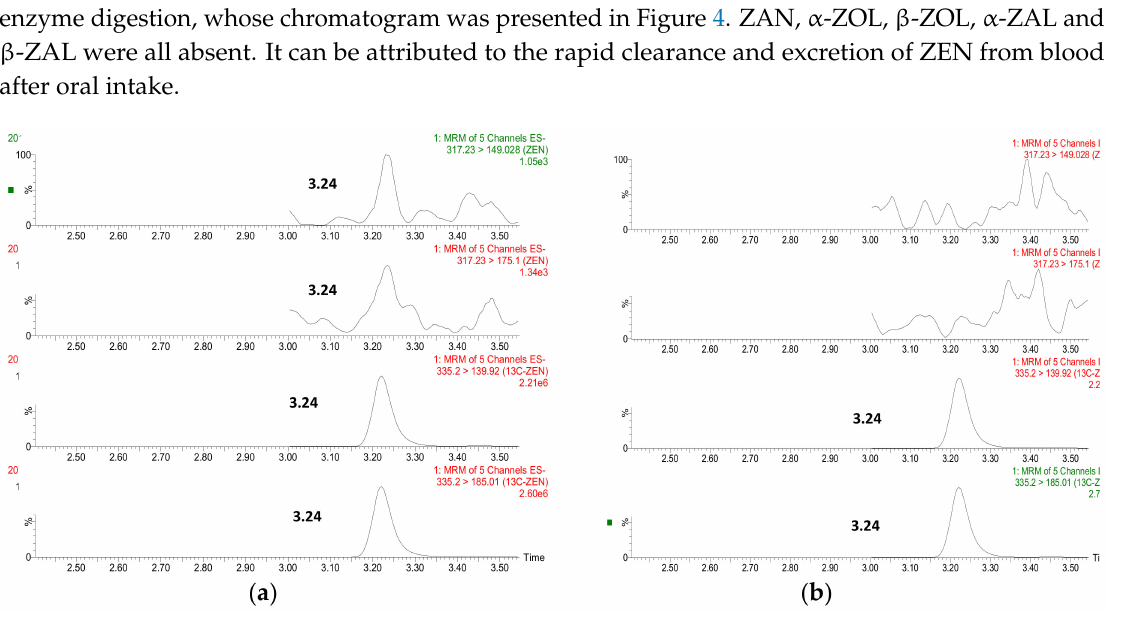
Figure 4. Chromatograms of a positive sample ( a ) and a negative sample ( b ).